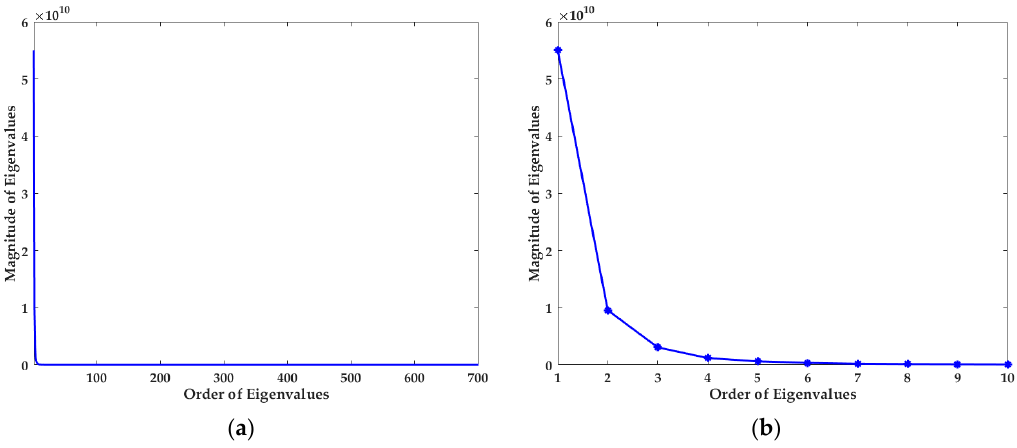
Figure 9. ( a ) All of the eigenvalues and ( b ) the ten largest eigenvalues of PCA.